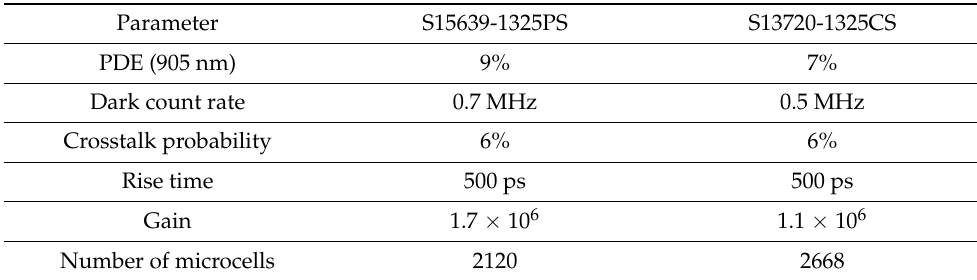
Table A1. Comparison of the two types of